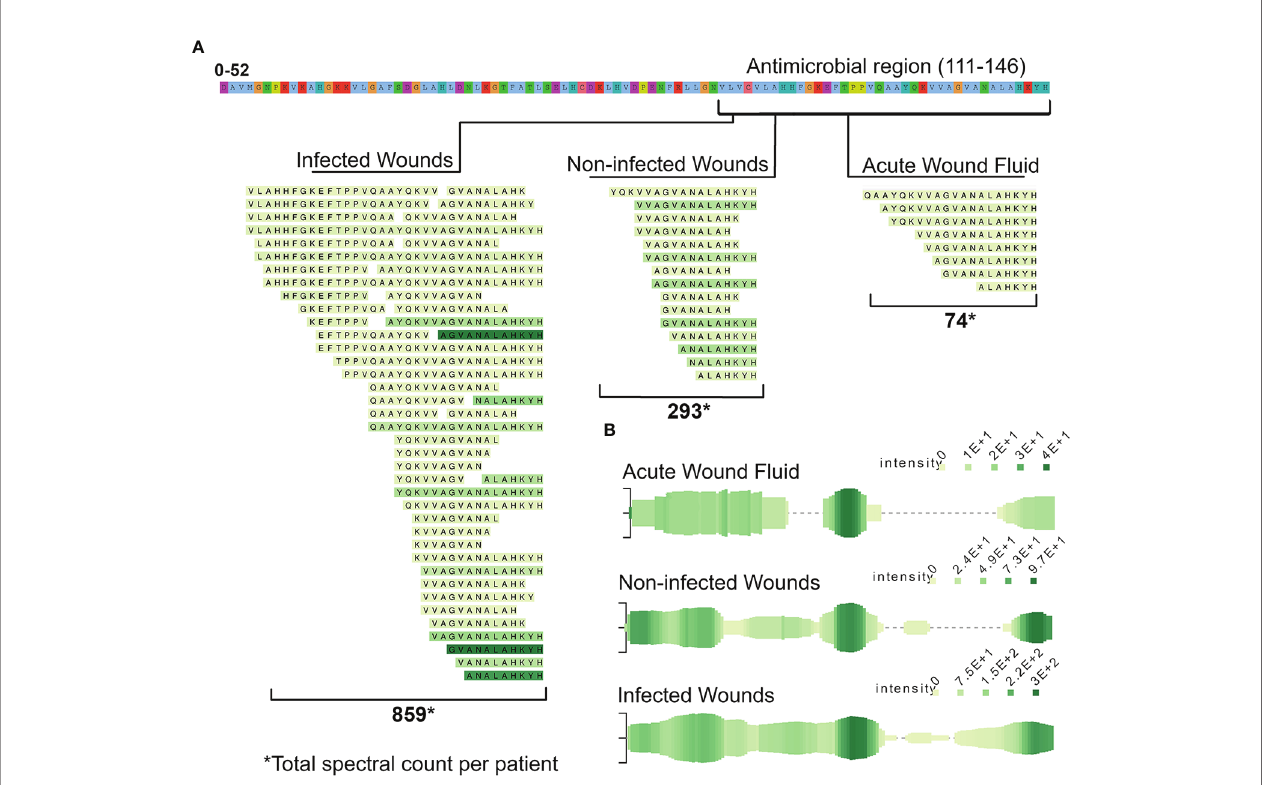
FIGURE 5 | Presence of peptides derived from the antimicrobial C-terminal (112 – 147) of hemoglobin subunit beta across the different wound fl uids. (A) To elucidate the difference in peptide expression of the region, a peptide alignment map was made, depicting the found peptides, aligned to the parent sequence of hemoglobin. The color intensity of the peptides re fl ects the average spectral count in the respective groups, ranging between 1 – 32. (B) Peptide pro fi les of the whole HBB - protein. Each green line along the x-axis represents an amino acid (AA) in the HBB sequence that is found in a peptide. The vertical size of the line is proportional to the number of peptides containing that AA while the color intensity is proportional to the